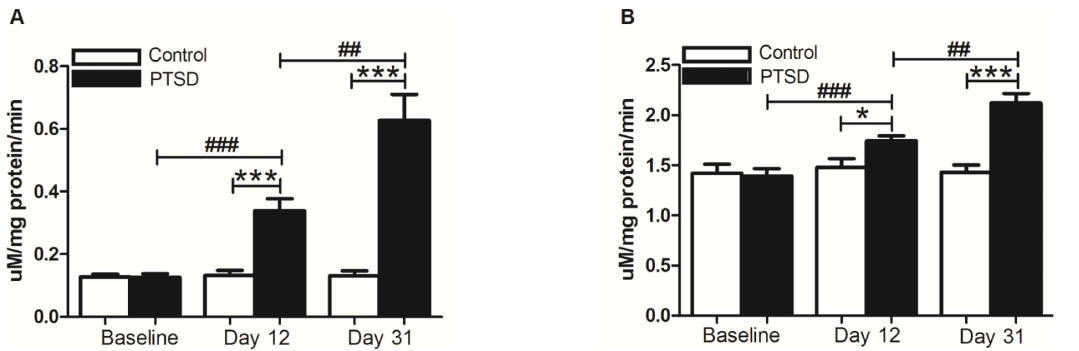
Figure 5. Reactive oxygen species in the blood. Superoxide (A) and total ROS (B) in the blood were measured between groups and within groups at three time points during the predator exposure/psychosocial stress regimen. Superoxide and total ROS were at approximately the same level for the PTSD and control groups at the beginning of the experiment, but progressively rose during stress. All data are presented as mean 6 SEM. *p , 0.05, ***p , 0.0001 relative to the control group. ## p , 0.001, ### p , 0.0001 relative to the previous measurement of the same group.